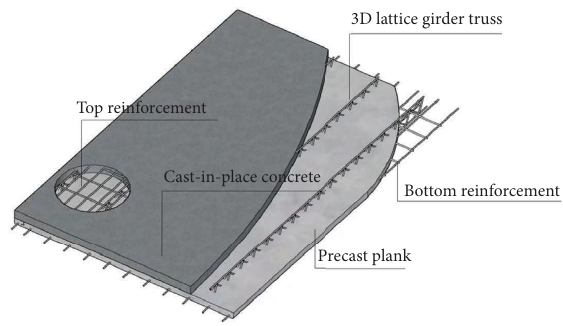
Figure 1: Lattice girder